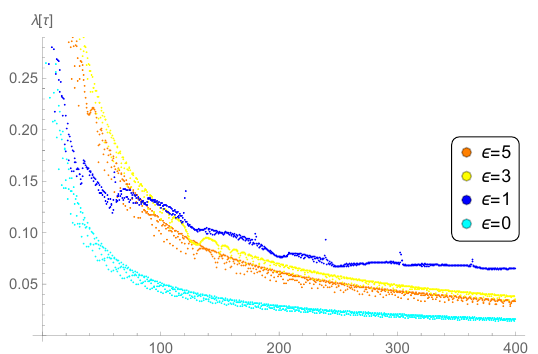
Figure 1 . For various values of the parameter (cid:15) de(cid:12)ning the deformation of the Sfetsos-Thompson solution given by eq. (3.19) we show the evolution of the Lyapunov coe(cid:14)cient (whose t ! 1 limit is the Lyapunov exponent). The initial conditions for our analysis are, (cid:31) (0) = 0 : 5, (cid:17) (0) = 0, _ (cid:31) (0) = 0 : 1, _ (cid:17) (0) = 0 : 1 with the parameter E (cid:12)xed such that the Hamiltonian